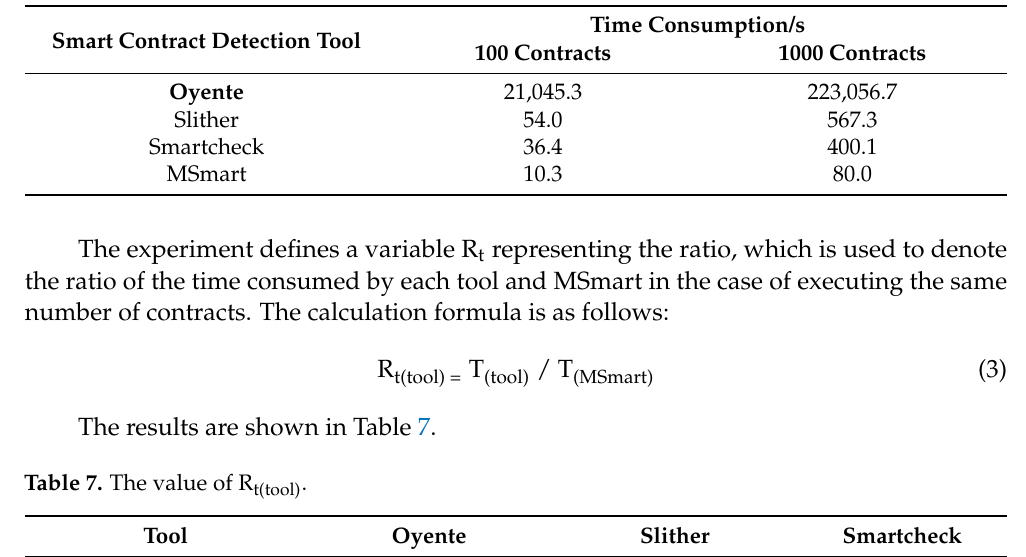
Table 6. Comparison of MSmart and other tools for time efficiency.